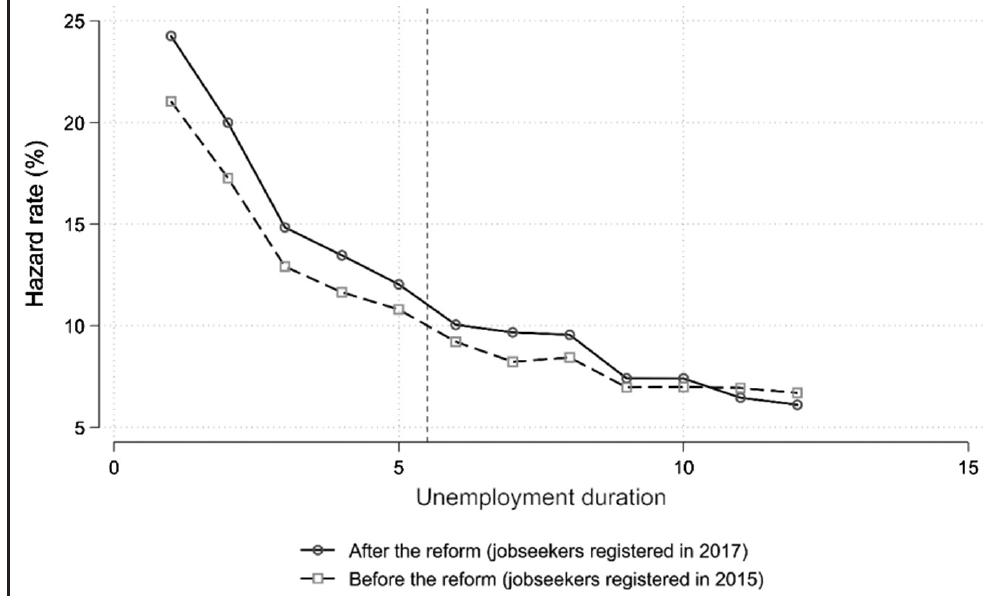
Figure A2 The job-finding rate of jobseekers aged 40–43 years as a function of the elapsed unemployment duration, before and after the